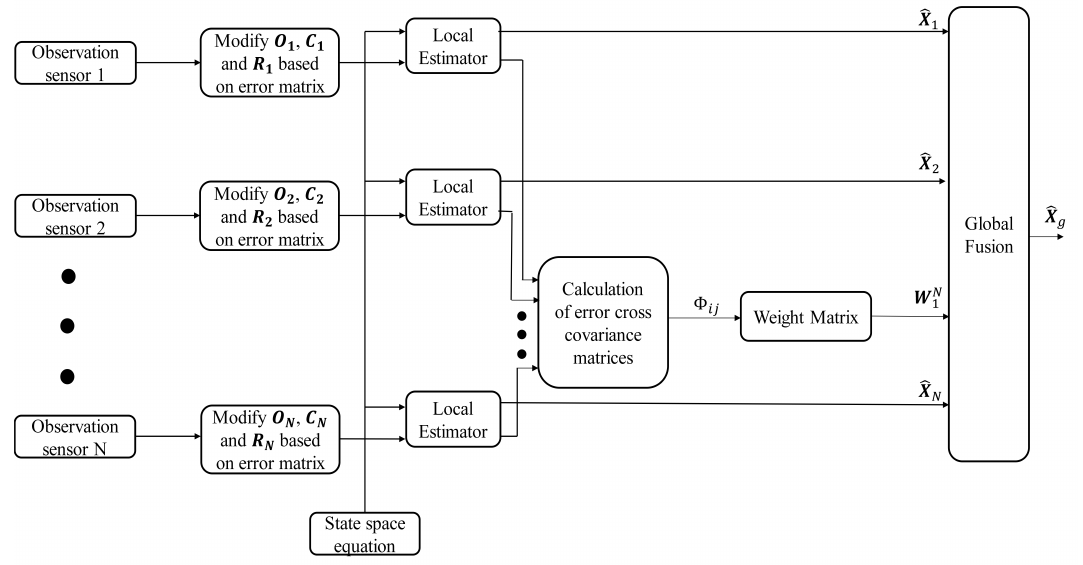
Figure 4. Block diagram of proposed sensor fusion technique.